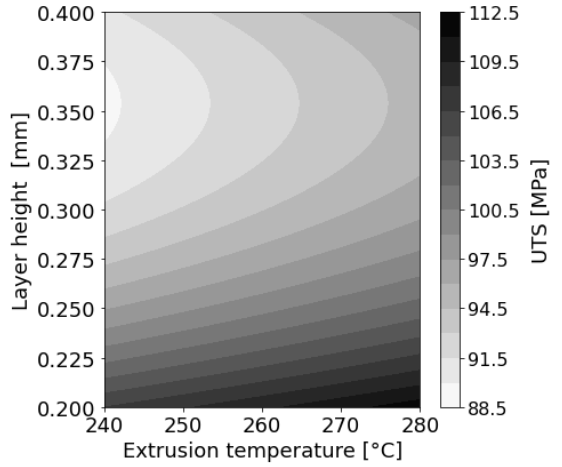
Figure A8. Contour plot for T ext and h according to the ML-based prediction model.